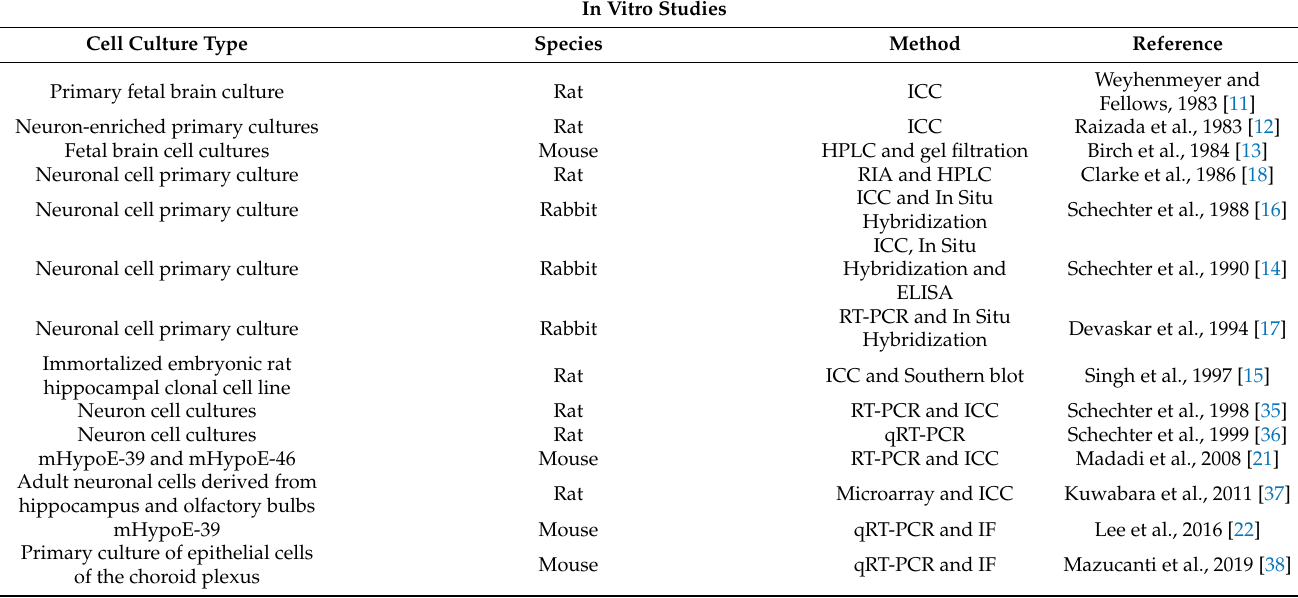
Table 1. Representative publication confirming the neuronal insulin expression in vitro and in